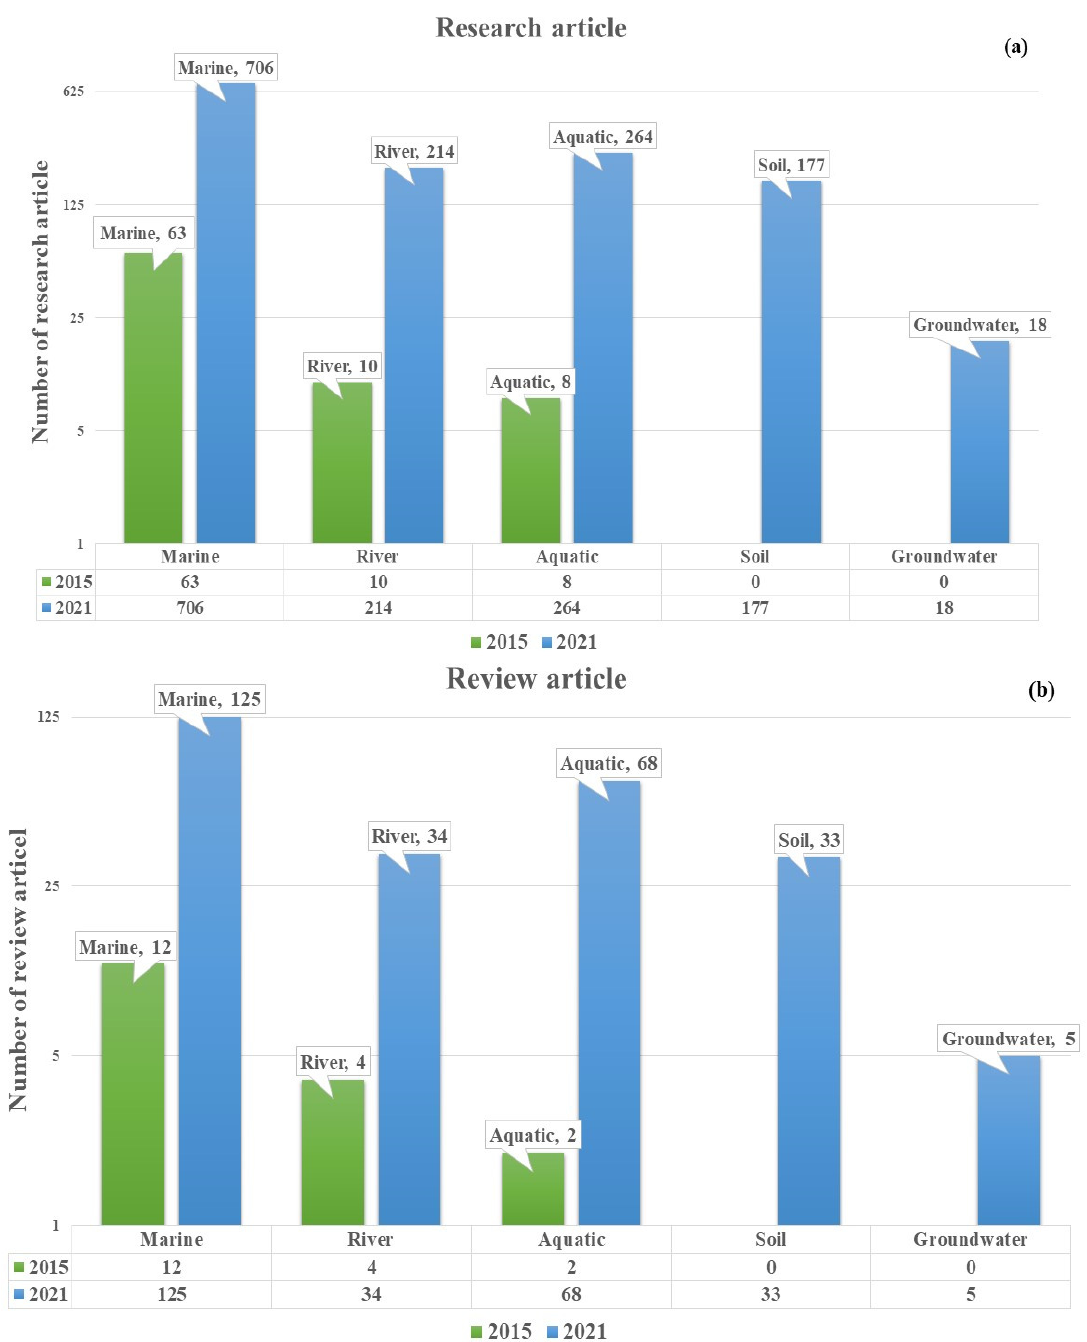
Figure 3. Articles on microplastics in different environments from 2015–2021, ( a ) research and ( b ) review microplastic articles (Source: web of science; search word: microplastic in marine, river, aquatic, soil, and groundwater).